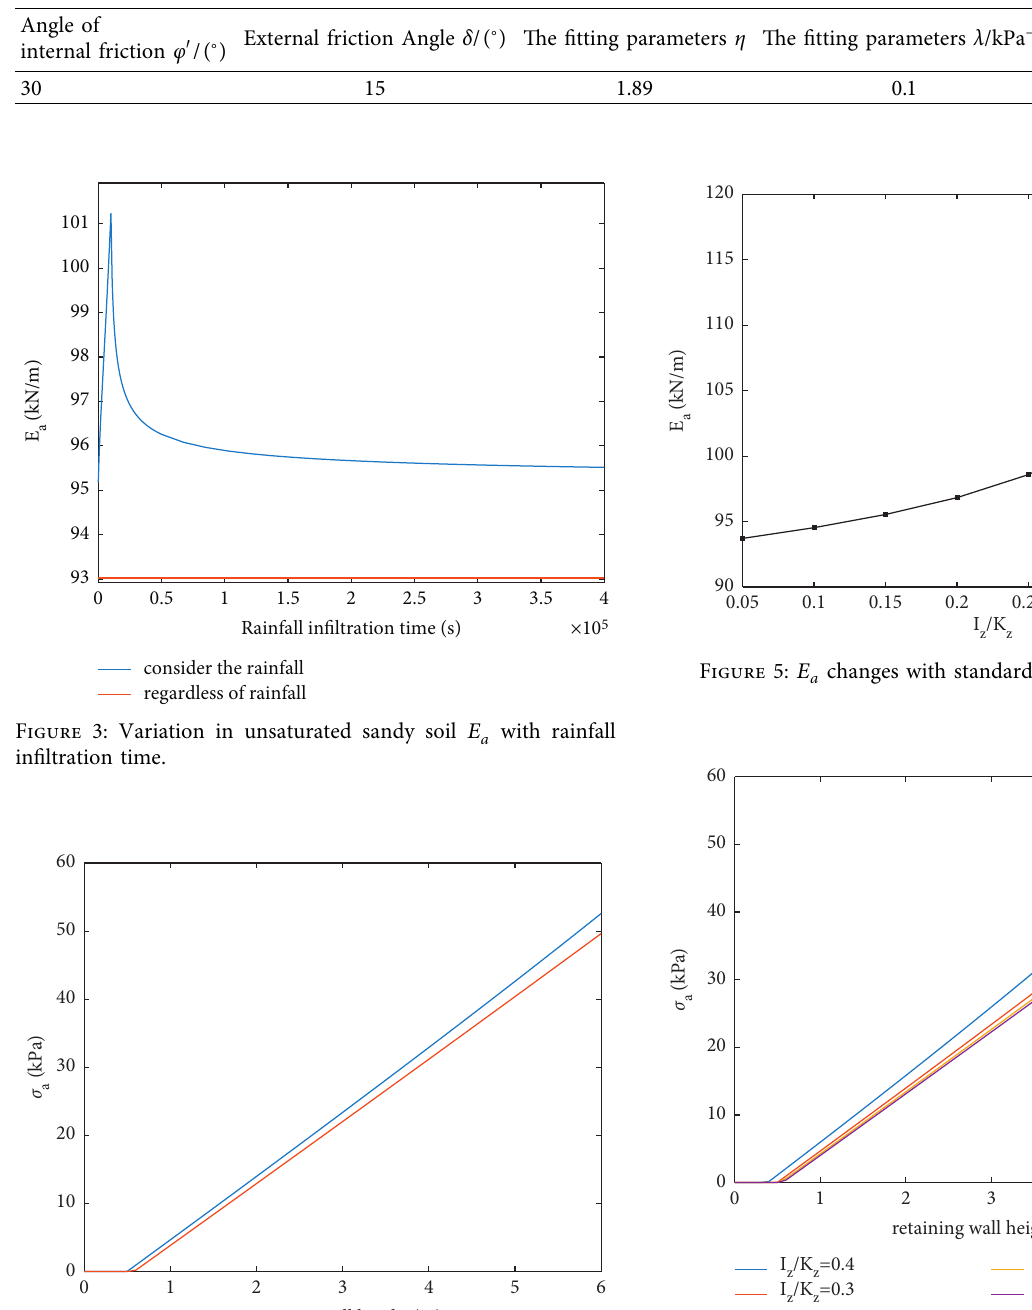
Table 1: Engineering filling parameters.